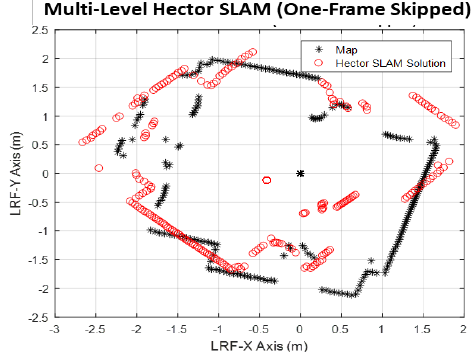
Figure 12. Hector SLAM Performance During Second Experiment with One Frame Skipping During Harsh Maneuver